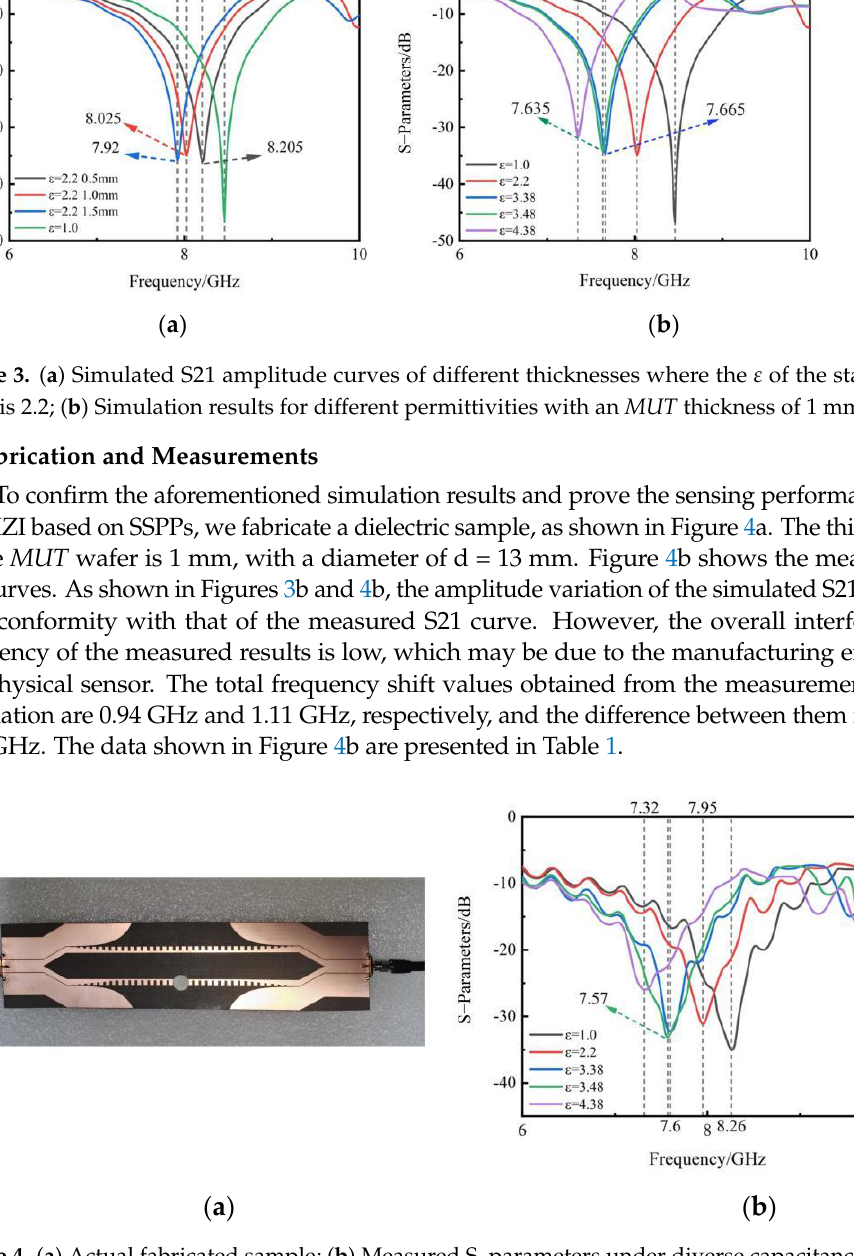
Figure 4. ( a ) Actual fabricated sample; ( b ) Measured S − parameters under diverse capacitances.